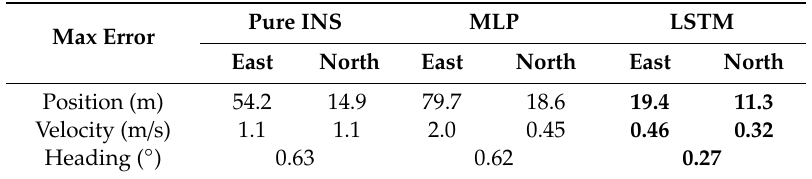
Table 6. Max error of position, velocity, and heading during 120 s GNSS outages in di ff erent